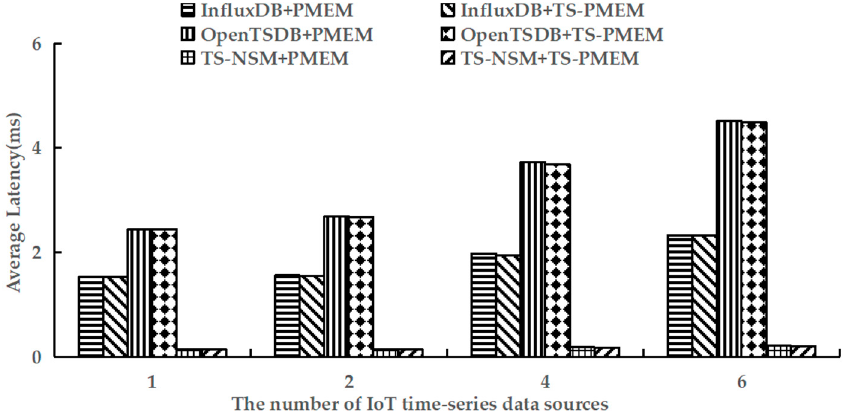
Figure 10. Average random query latency under